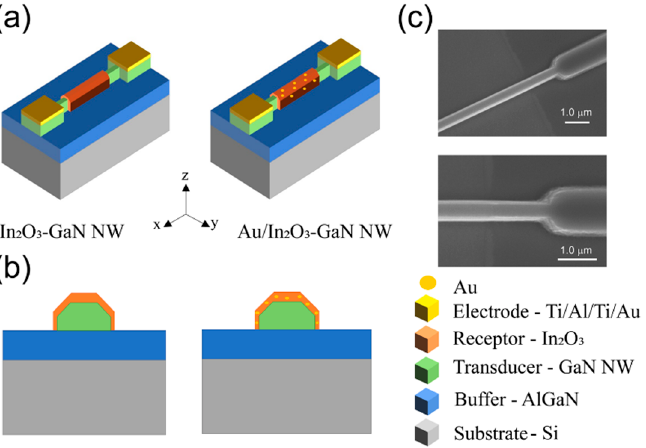
Figure 1. Schematics of proposed In 2 O 3 -GaN-NW-based sensors: ( a ) device structure, ( b ) cross-sec- tion at the center along y/z-axis, and ( c ) top view of SEM images of GaN NW. EDS analysis was performed to characterize the composition of In 2 O 3 and Au/In 2 O 3 sensors, as observed in Figure 2a,b.